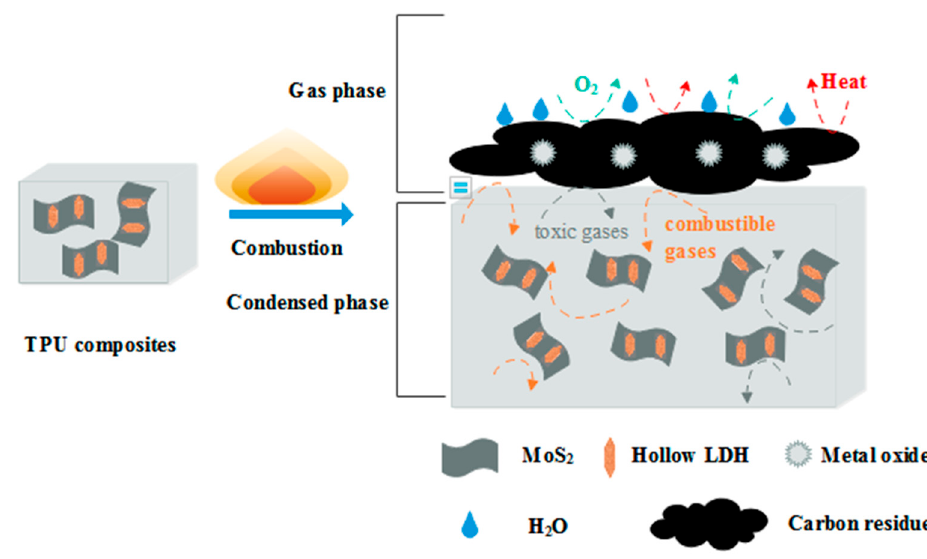
Figure 15. Illustration of the flame retardant mechanism of TPU/LDH/MoS 2 .